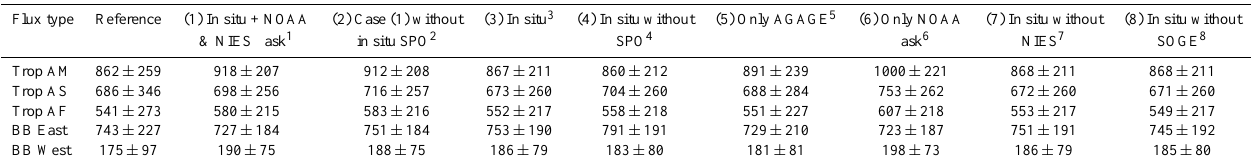
Table 4. Reference and optimally estimated five-year averaged surface fluxes and errors for emissions from tropical plants and biomass burning in Table